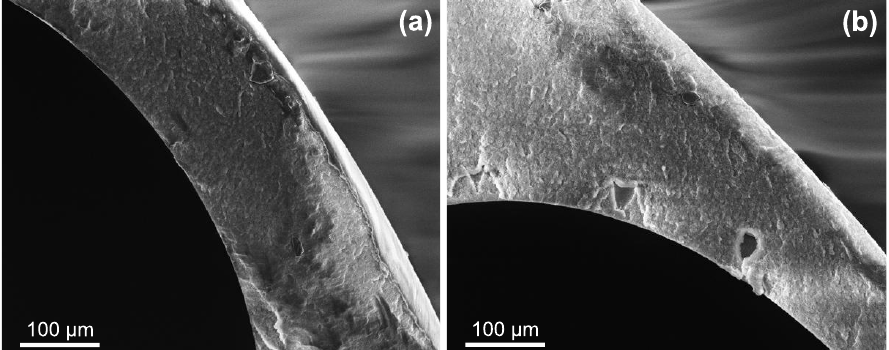
Figure 6. Cross sectional scanning electron mircoscope (SEM) images of varied bore-fluid composition. ( a ) ID10 with EtOH 1:1 H 2 O; ( b ) ID10 with DMAc 1:1 H 2 O. ID10 with pure H 2 O shown in Figure 3b. For detailed parameters see Table